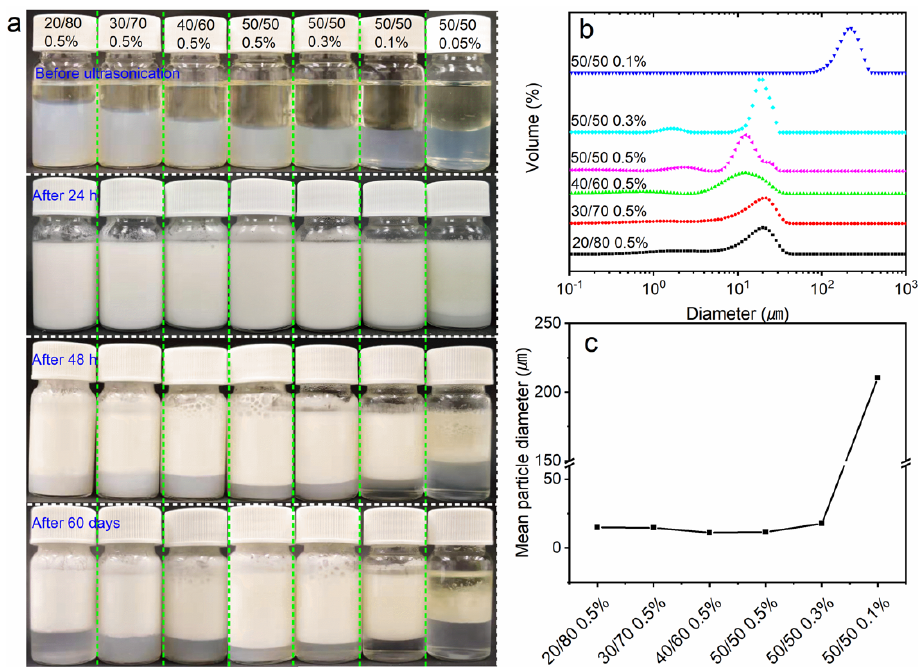
Figure 5. Appearance of soybean oil in water emulsions prepared by ChNCs (DES 100-1 ) before and after sonication and after storage for 24 h, 48 h, and 60 days ( a ). Particle size distribution of emulsion droplets ( b ) and their mean diameter ( c ).